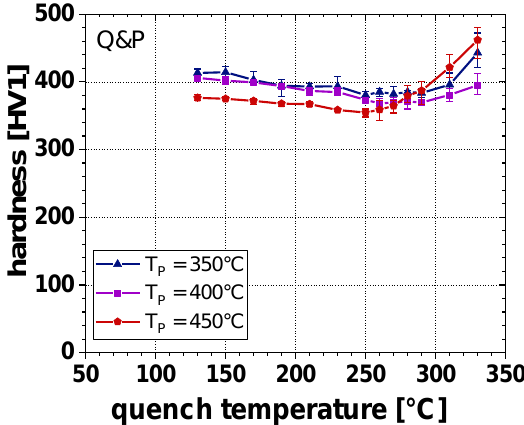
Figure 10. Vickers hardness as a function of T Q for a T P of 350, 400, and 450 °C.